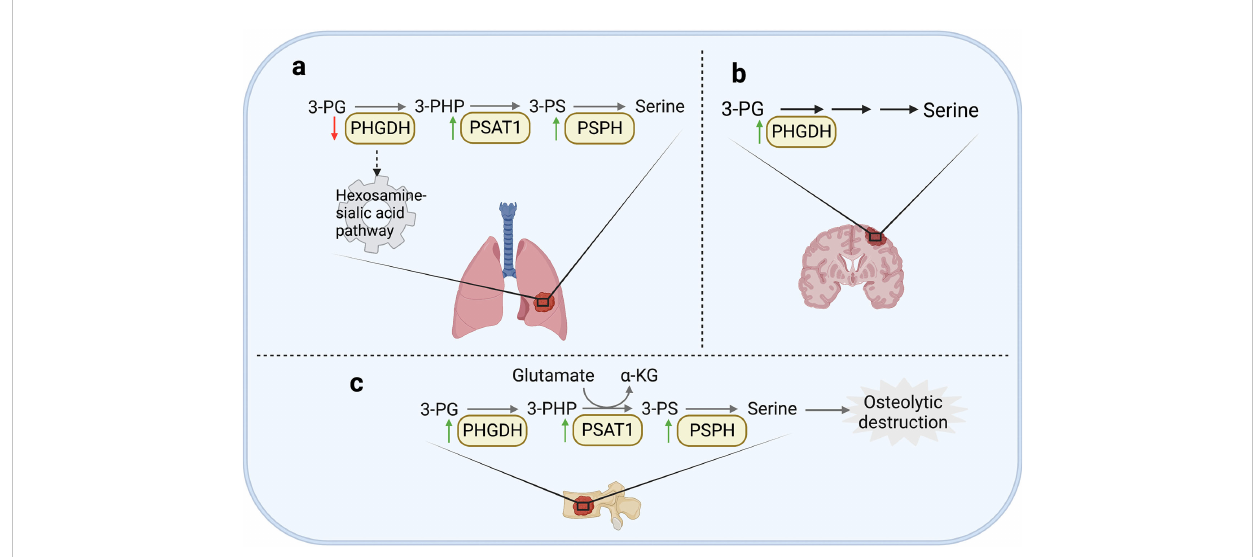
FIGURE 3 Serine and glycine metabolism in metastases. (A) In lung, the enhanced expression of PSAT1 was widely observed in various cancer tissues. In addition, PSPH is also observed to be upregulated in lung metastasis of NSCLC cells and melanoma cells. However, the low expression of PHGDH can enhance cell migration and invasion in breast cancer by activating hexosamine sialic acid pathway. (B) In brain, PHGDH can promote formation of brain metastases by enhancing serine synthesis. (C) In bone, PSPH, PSAT1 and PHGDH are all upregulated in bone metastases of breast cancer, resulting in osteolytic